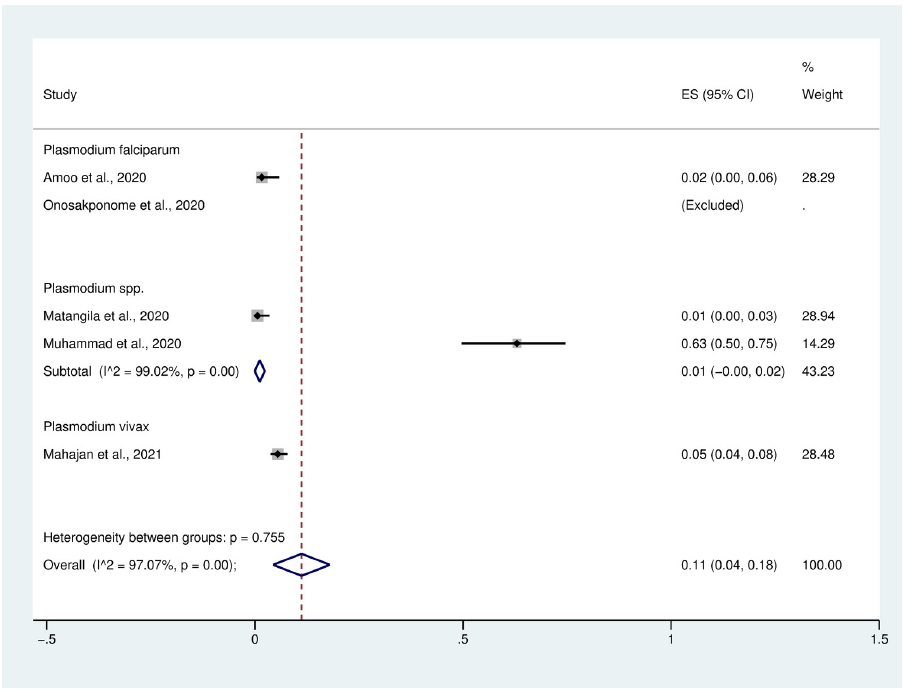
Fig 4. Forest plot of the subgroup analysis of the pooled prevalence of Plasmodium spp. infection among patients with COVID-19. ES, effect size; CI, confidence